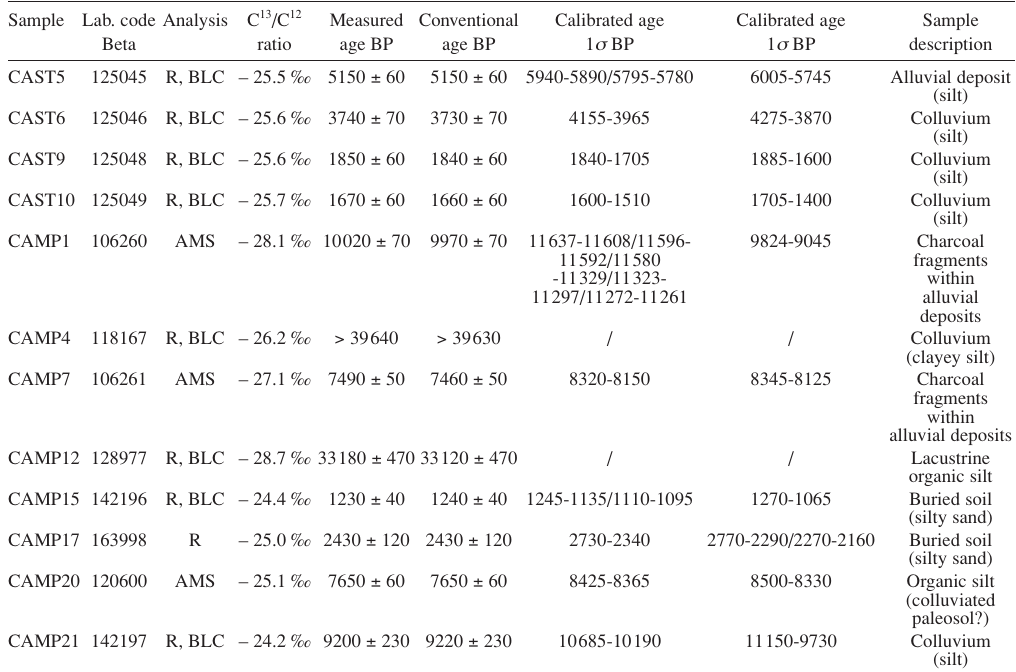
Table I. Radiocarbon dates of samples collected in the investigated areas and in the trenches excavated across the Mt. Vettore and Laga Mts. faults. R - radiometric technique; BLC - bulk/low carbon material procedure; AMS - accelerator mass spectrometry technique. Sample Lab. code Analysis C 13 /C